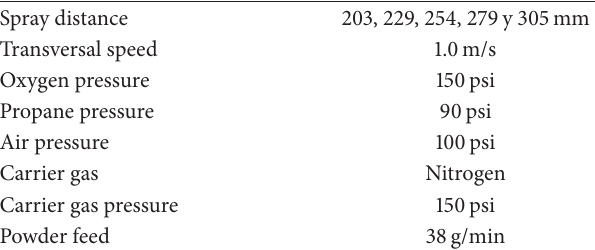
Table 2: Deposition of powder conditions of CoNiCrAlY by